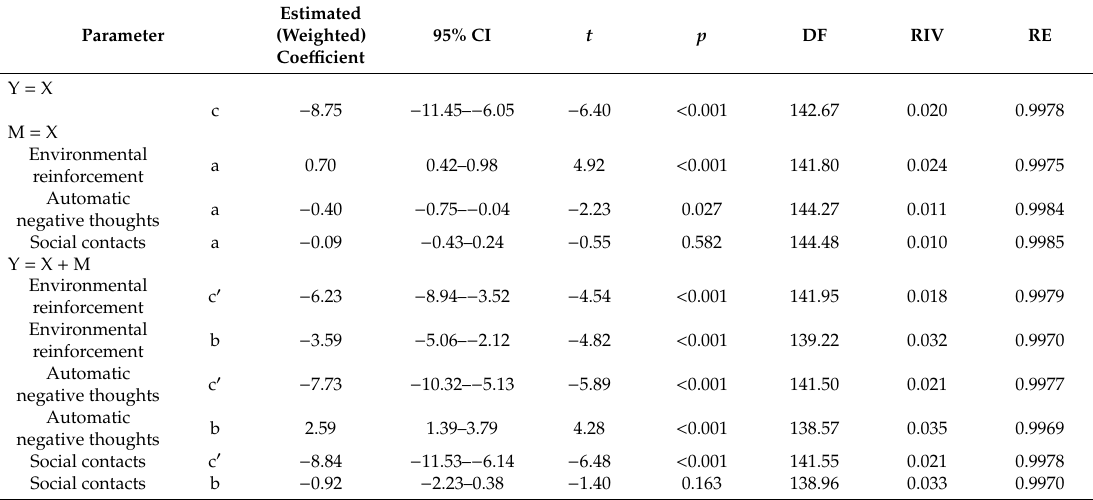
Table 6. Analysis of mediation for positive environmental reinforcement, negative automatic thoughts, and social contacts at the post-intervention time point for the BACC